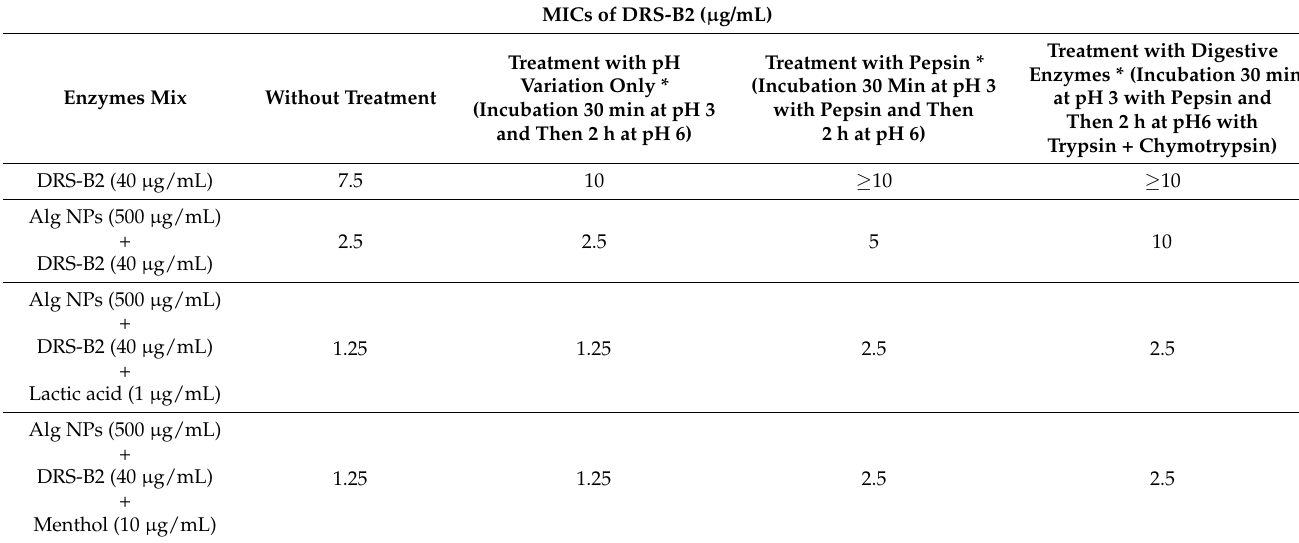
Table 6. Effects of digestive enzymes on Alg NPs + DRS-B2 + lactic acid or Alg NPs + DRS-B2 + menthol antibacterial